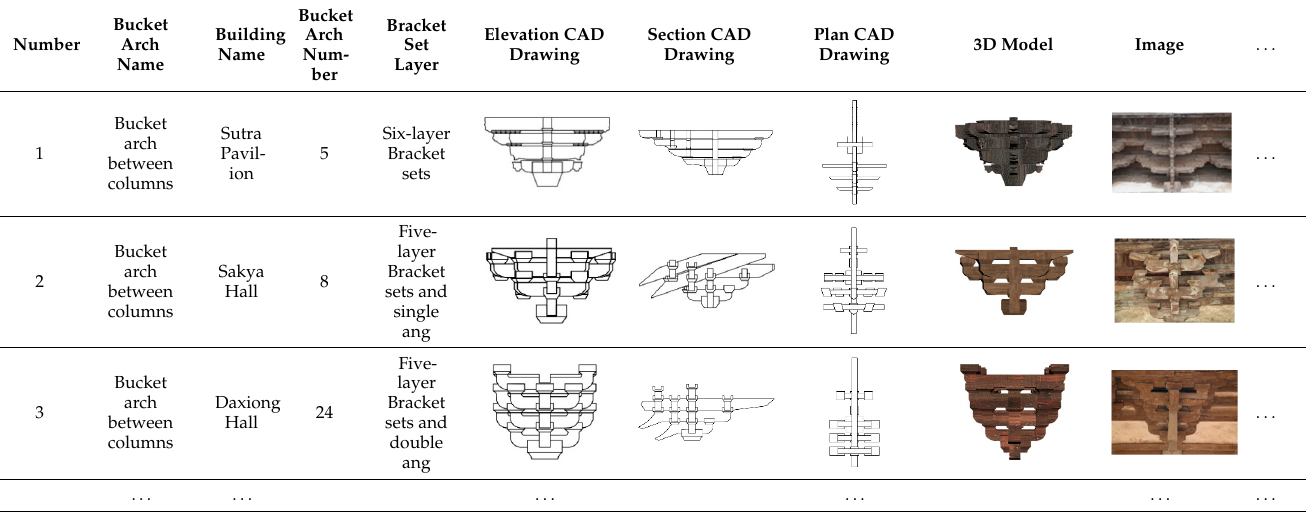
( b ) Figure 9. Preprocessed data: ( a ) point cloud and ( b ) UAV image. (2) CAD Drawings The CAD drawings accurately recorded the structures and dimensions of the buildings. In our study, the CAD drawings of overall buildings and important building elements were drawn in AutoCAD by measuring the point clouds. Figure 10 shows the CAD drawings of the plane, façade, and side elevation of the Sutra Pavilion. Many architectural heritages in China were timber structures, especially in Shanxi, China. This kind of structure was complex, but it resulted in beautiful and flexible shapes, and strong oriental characteristics. Therefore, a detailed CAD drawing was drawn for the building elements made of timber, such as bucket arches, caissons, and beam frames. Table 2 shows the plane, elevation, and sections of a bucket arch.